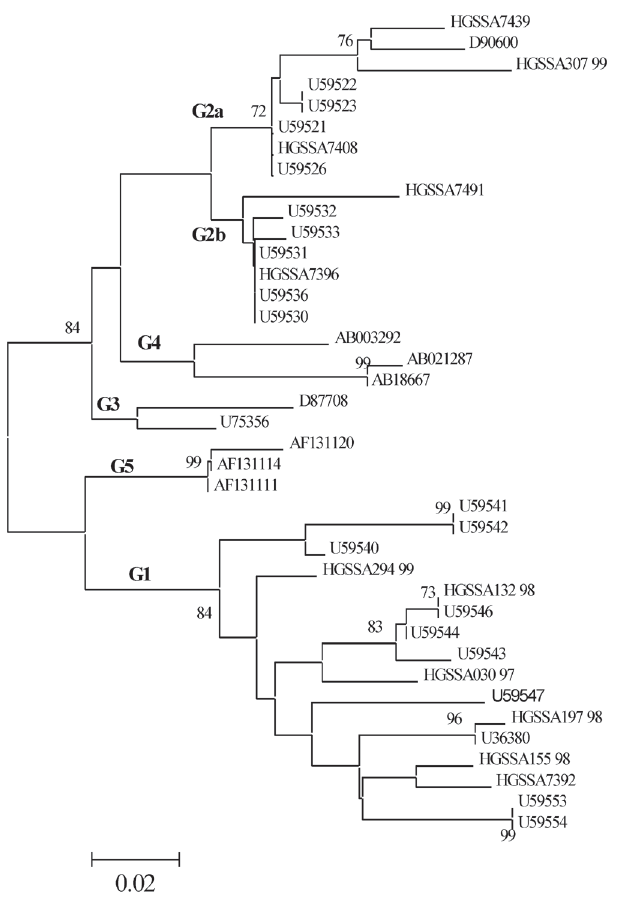
Figure 3. Neighbor-joining tree of 135 nt fragments of GBV-C/HGV (5’NCR) from previously published reference strains and from our study popula- tion. For previously published reference strains, the GenBank accession numbers are indicated. The genotype designations used correspond to designations from previous publications. They are indicated on the branches. The bootstrap test of phylogeny was performed with 1000 replicates and values equal to or higher than 70 are